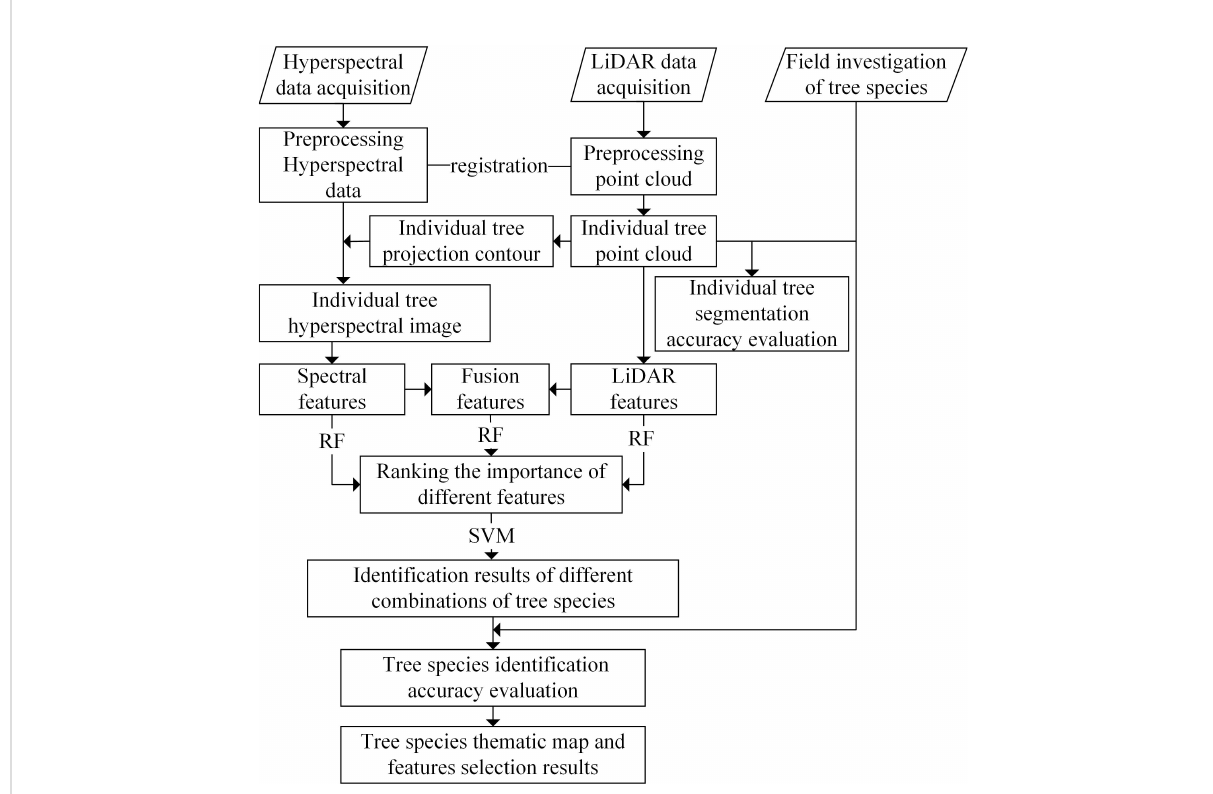
FIGURE 2 Flowchart for the identi fi cation of tree species based on fusion of the hyperspectral and LiDAR